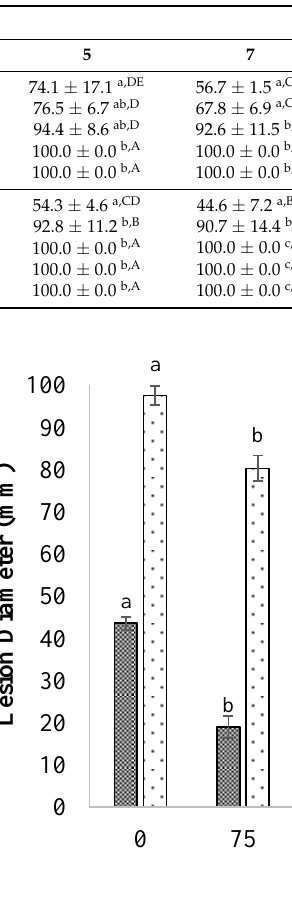
Figure 4. Effect of BCNCs/GelA − CEO treatments at different concentrations (75 – 2400 μ L/L) against P. expansum and B. cinerea , artificially inoculated into apple fruit (in vivo), after 21 days of storage at 25 °C. Each lesion diameter is an average of 15 replicates. For any investigated fungus, different letters above the bars denote a statistically significant difference according to the Tukey test ( p < 0.05).